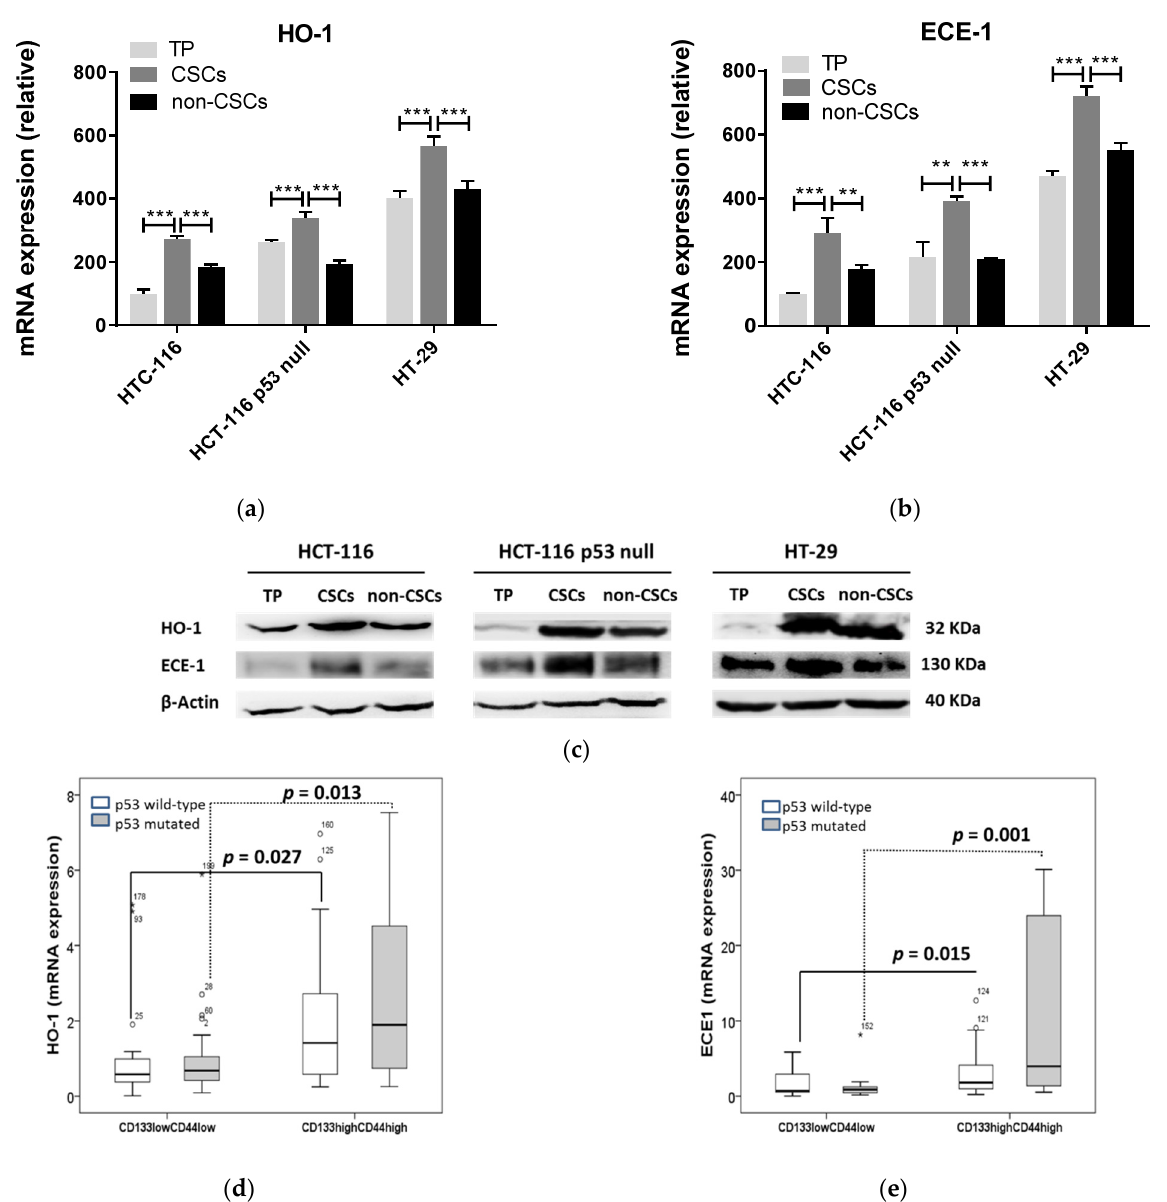
Figure 3. HO-1 and ECE-1 expression is higher in the CSCs vs. non-CSCs subpopulation in CRC regardless of p53 status. The CSCs and non-CSCs subpopulations from HCT-116, HT-116 p53 null, and HT-29 cells were obtained as described in the Materials and Methods section and used to measure mRNA expression of ( a ) HO-1 and ( b ) ECE-1. Data represent the relative expression of HO-1 and ECE-1 to the TP of HCT-116 and express the mean ± SD of two experiments performed in duplicate. **, p < 0.01; ***, p < 0.001. ( c ) Protein expression of HO-1 and ECE-1 in HCT-116, HT-116 p53 null, and HT-29 cells in the TP, CSCs, and non-CSCs subpopulations. β -actin was used as housekeeping. TP: total population; CSCs: cancer stem cells subpopulation; non-CSCs: non-cancer stem cells subpopulation. Box plots representing the relative mRNA expression of ( d ) HO-1 and ( e ) ECE-1 in CRC samples from patients considering the levels of CSCs markers and the status of p53. Data represent the median and the interquartile range of the genes analyzed. *, distant values more than 3 box lengths from 75th percentile; °, distant values more than 1.5 box lengths from 75th percentile.